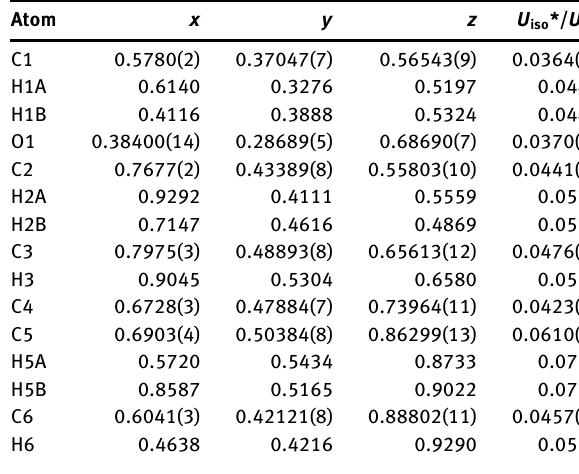
Table 2: Fractional atomic coordinates and isotropic or equivalent isotropic displacement parameters (Å 2